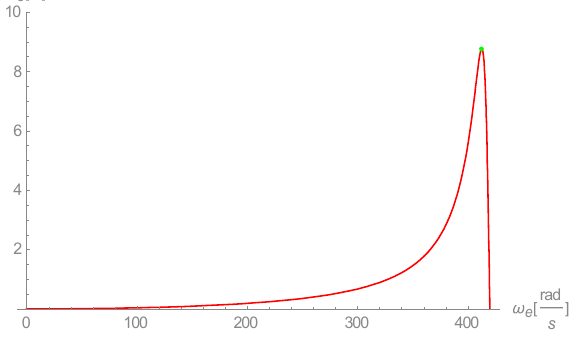
Figure 4. The curve obtained from Equation (29) with a green dot representing the result obtained in Equation (33).